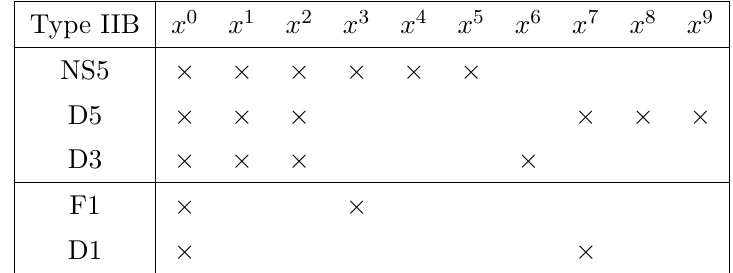
Table 2 . Occupation of space-time directions by NS5, D5, and D3 in Type IIB. The fundamental string F1 induces the electric theory, while the D-string D1 induces the magnetic